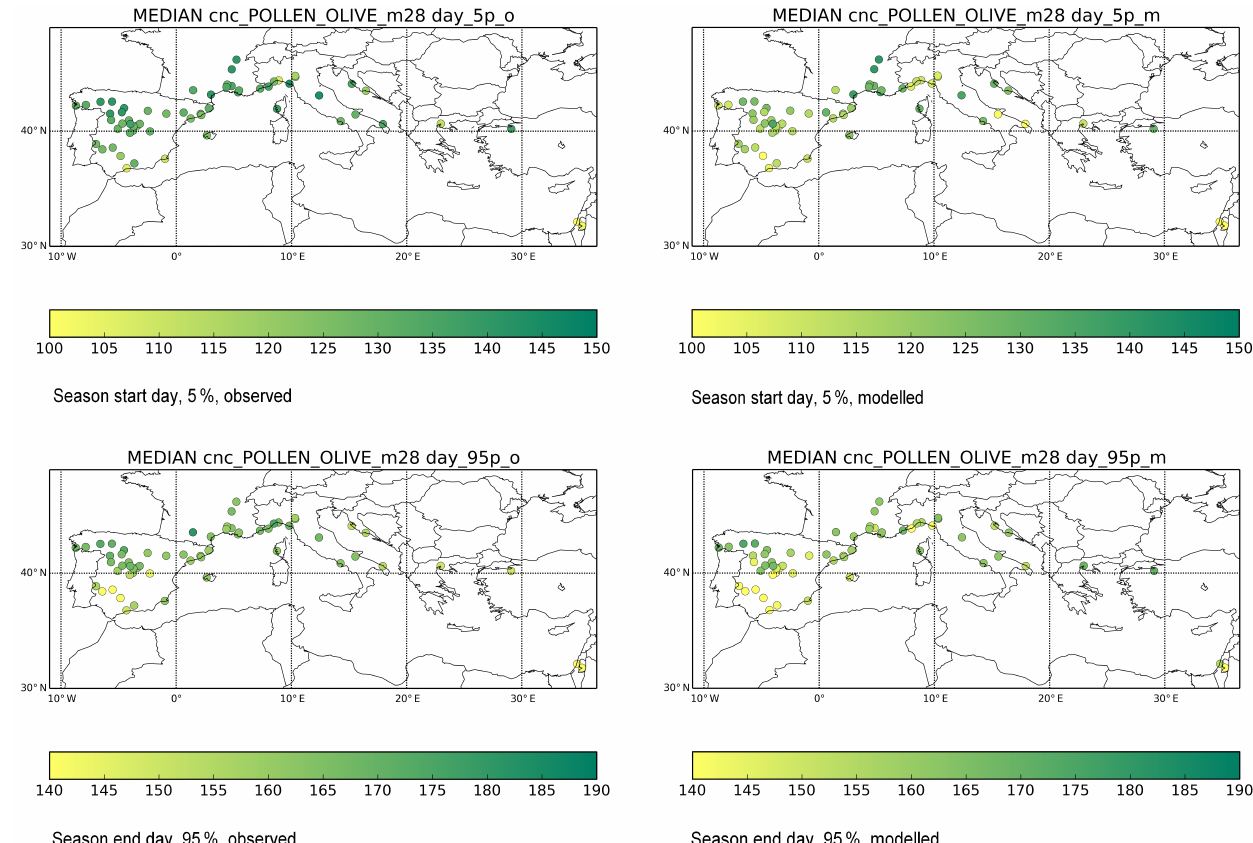
Figure 6. The start (5% of the cumulative seasonal concentrations) and the end (95% of the cumulative seasonal concentrations) of the olive season in 2014 as day of the year, predicted by the median of the ensemble and observed by the stations with a sufficient number of